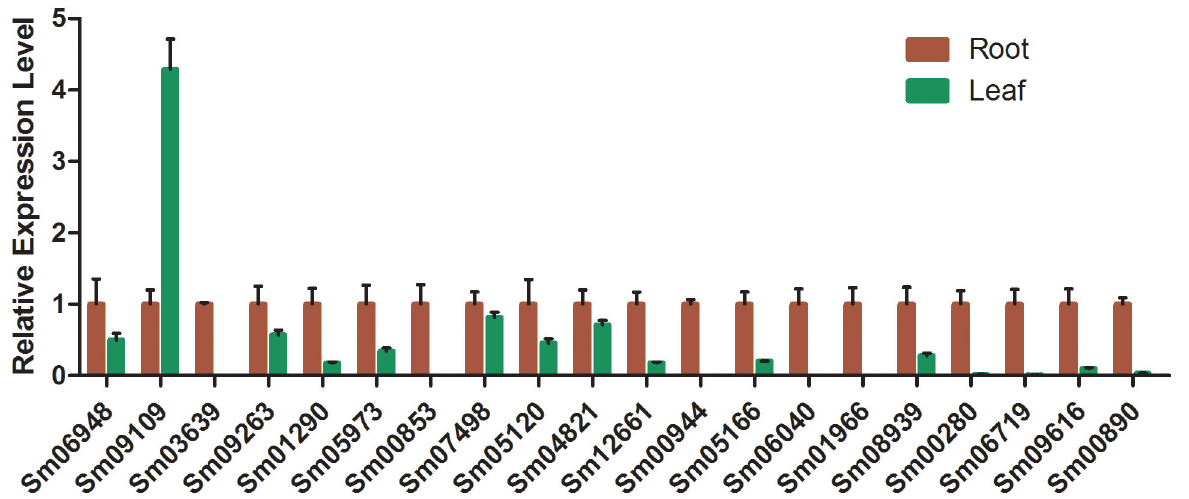
Figure 4. Relative expression levels of P450 genes in S. miltiorrhiza root and leaf. Total RNAs were extracted from root and leaf of 1-year-old S. miltiorrhiza and expression levels of P450s were analysed by quantitative real-time PCR. ACTIN was used as the internal reference gene and the relative abundance of each P450 genes in roots were compared to those in leaf, which were all set to be 1. Error bars indicate standard deviations of three biological replicates.